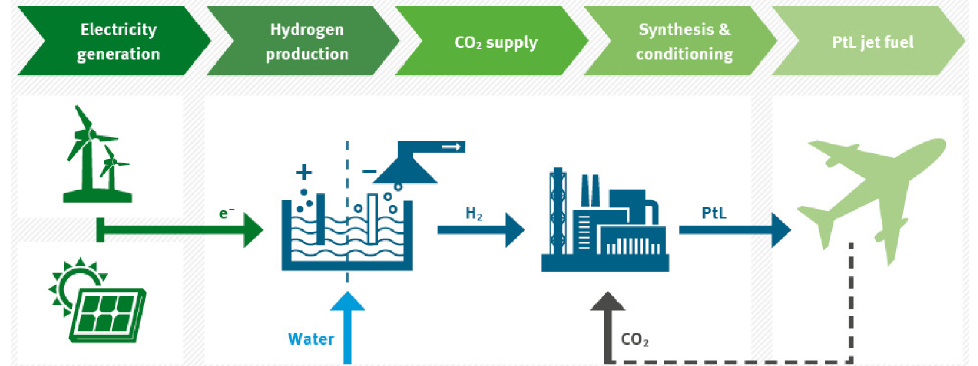
Figure 8. Generic Power-to-liquid production stages [75]. Source: LBST GmbH (2016). All rights